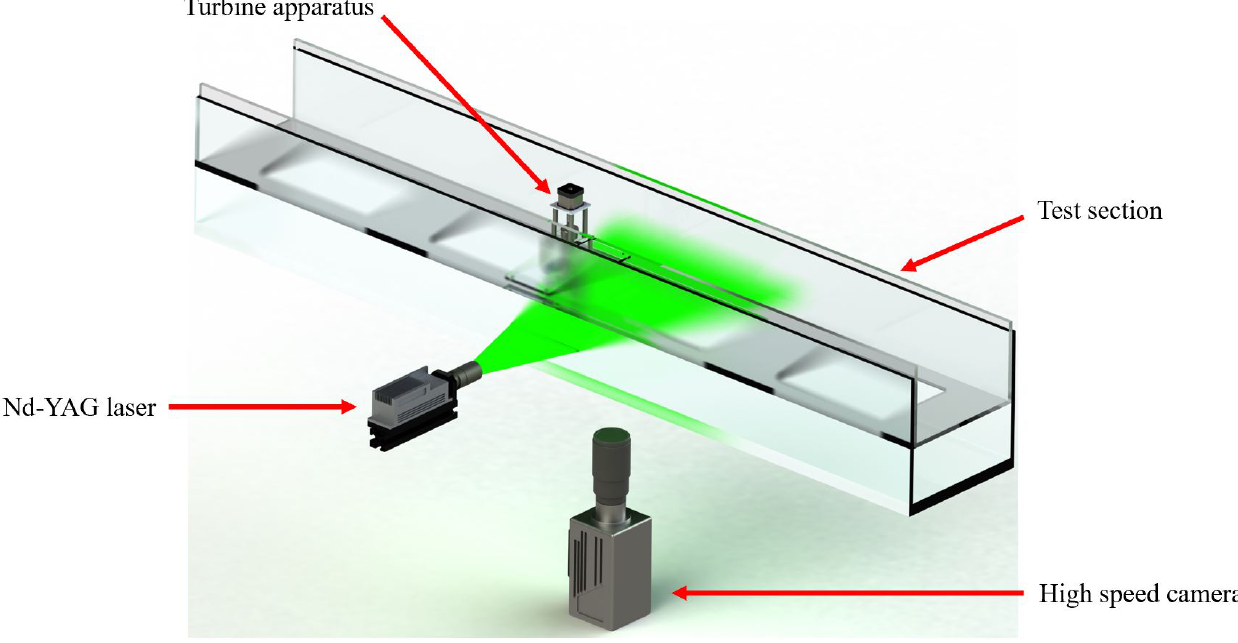
Figure 2. An overview of the monoscopic particle image velocimetry setup. The figure was adapted from